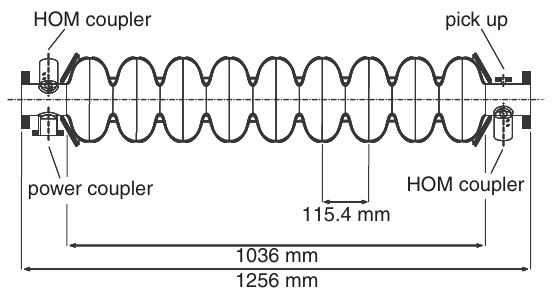
FIG. 1. Side view of a nine cell TESLA type cavity with the main power coupler, the pickup probe, and two higher order mode (HOM)